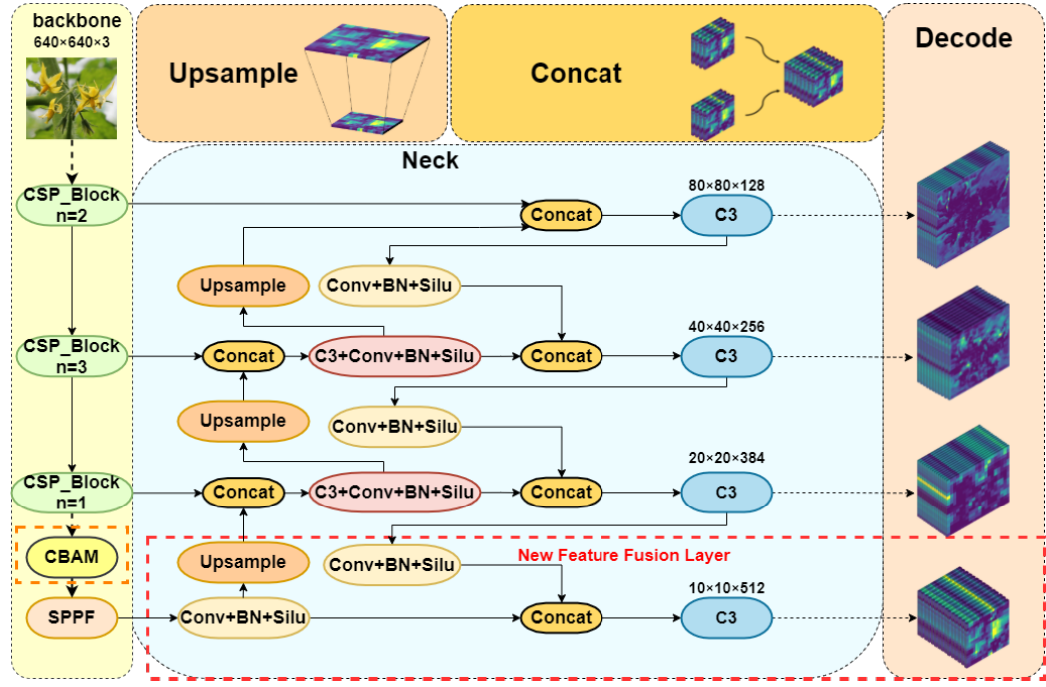
Figure 5. The architecture of FlowerYolov5.